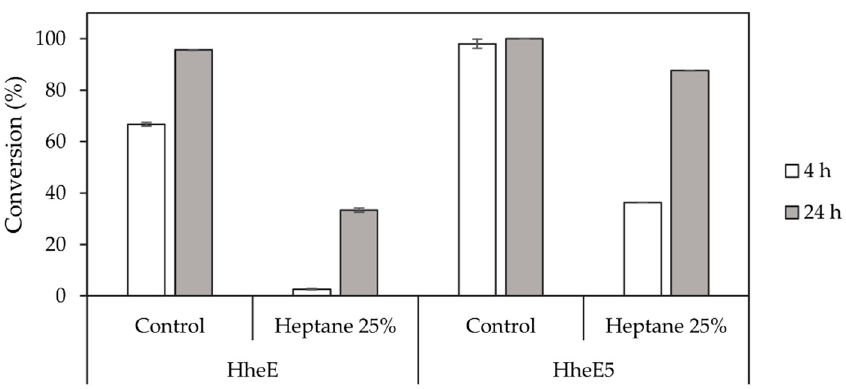
Figure 5. Conversion of each 10 mM epoxide 2 and 5 by HheE and HheE5, respectively, applied as whole cells in the presence and absence of heptane (25% v / v ) as organic phase. All experiments were performed in duplicate in 50 mM potassium phosphate buffer, pH 7.5 at 25 °C.